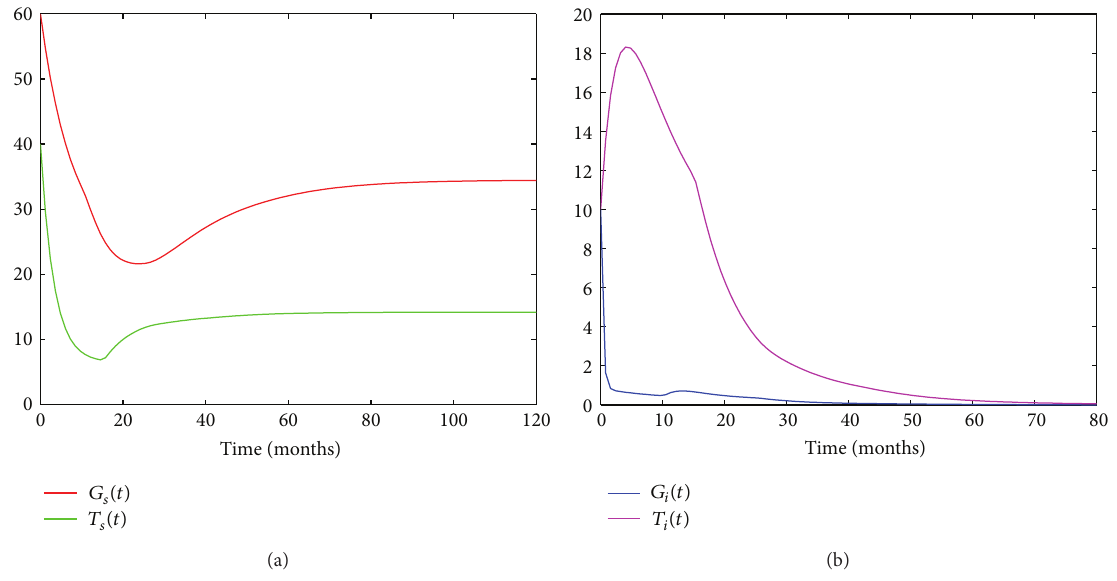
Figure 1: The infection-free equilibrium 𝐸 0 of system (3) is globally asymptotically stable when 𝜏 = 10 , 𝜔 = 15 , and R 0 ≤ 1 . The initial functions are ( 60,10, 40 , and 10).